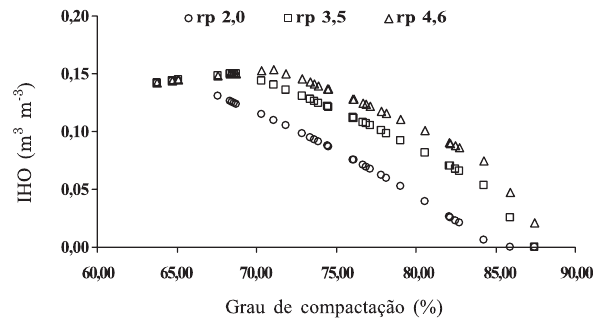
Figura 3. variação do intervalo hídrico ótimo em função do grau de compactação do solo para os valores de resistência à penetração de 2,0, 3,5 e 4,6